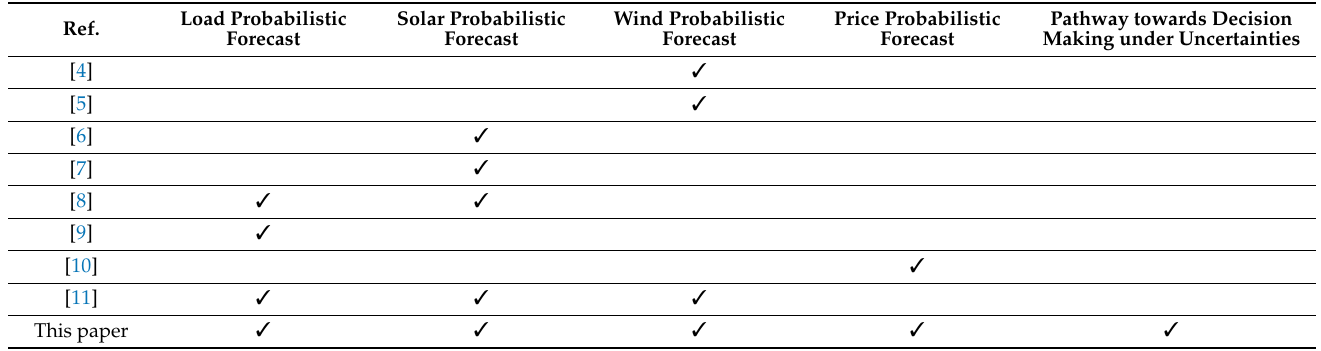
Table 1. Comparison of this paper with the literature reviewing probabilistic forecasting models and applications in smart grids and power